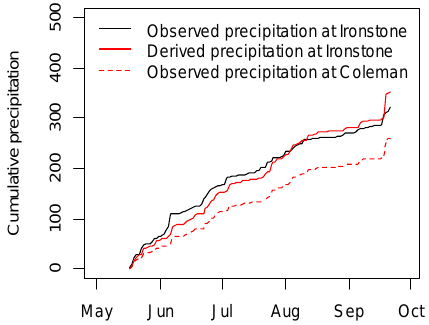
Fig. 5. Mean cumulative precipitation at Coleman, and observed and derived mean cumulative precipitation for the climate station Ironstone.